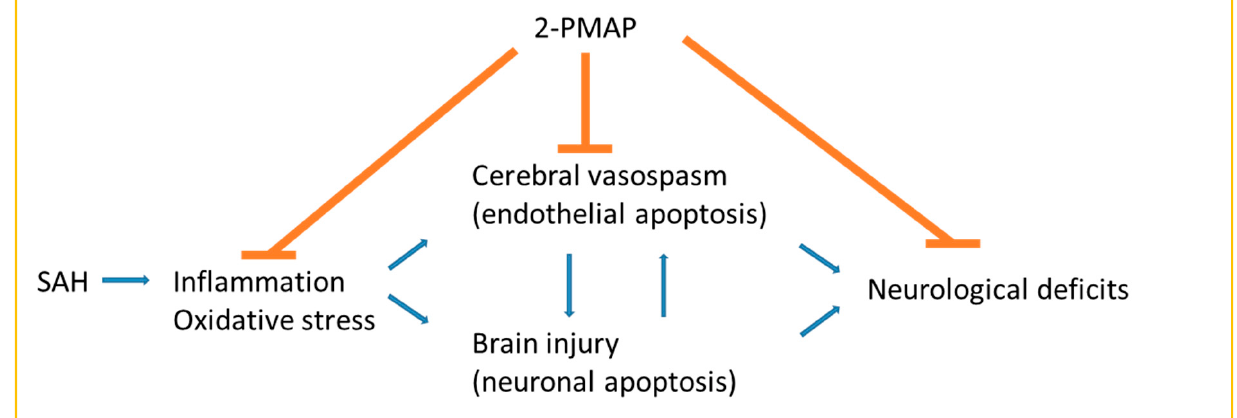
Figure 8. Schematic diagram of the regulatory role of 2-PMAP in SAH rats.